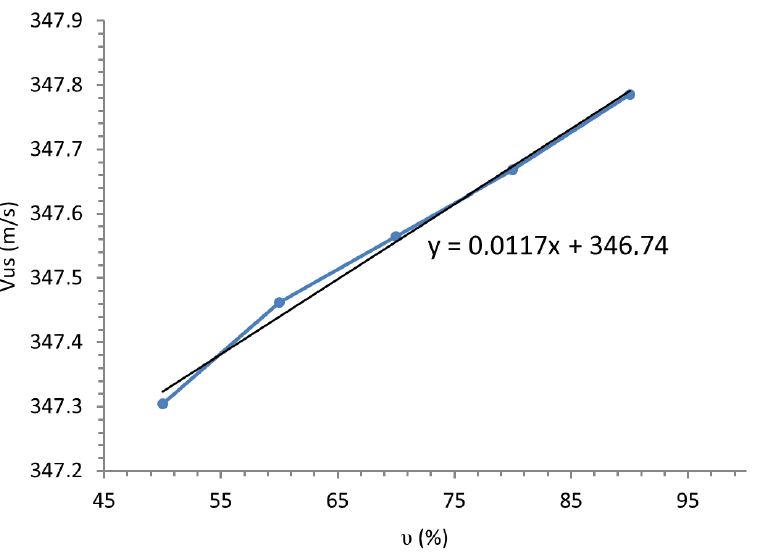
Figure 15. Dependence of the averaged ultrasonic wave propagation velocity as a function of air relative